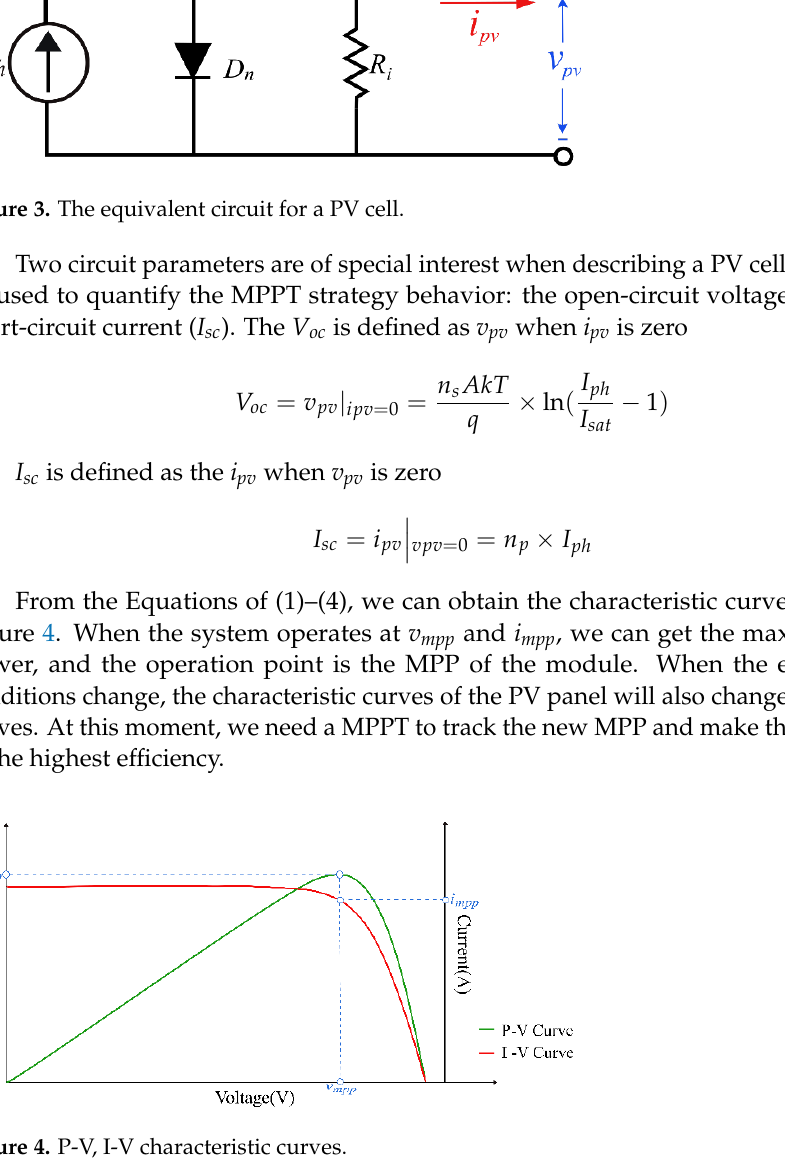
Figure 4. P-V, I-V characteristic curves .